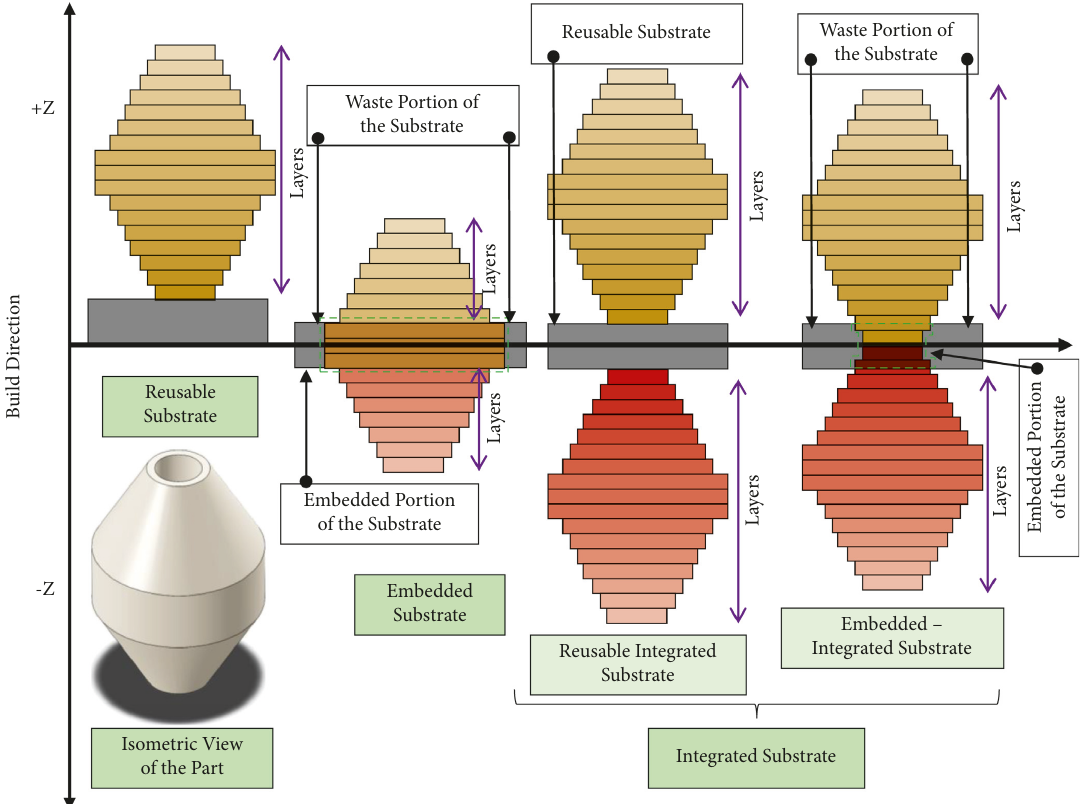
Figure 2: Substrate utilization methods for